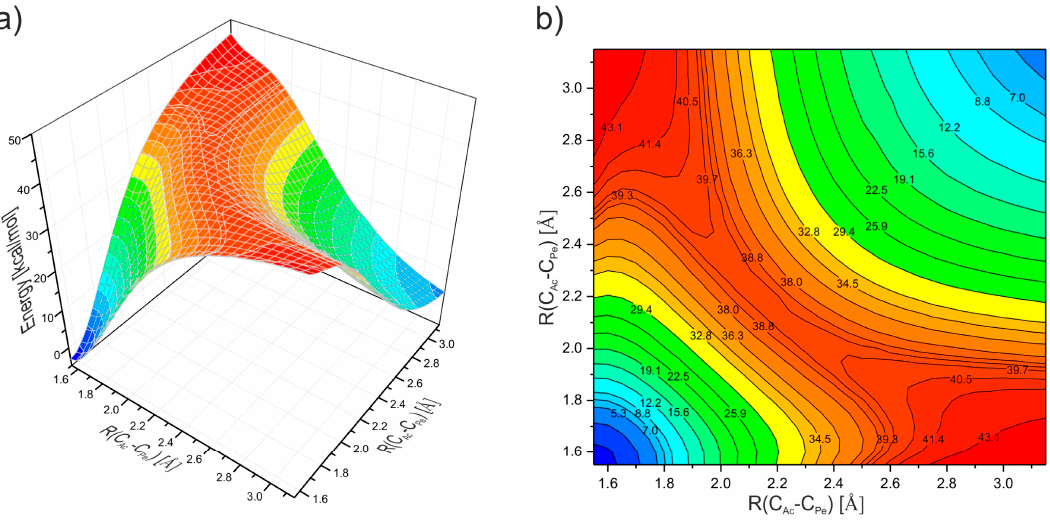
Figure 7. ( a ) Potential energy surface (PES) as a function of C Ac -C Pe distances for the cycloaddition reaction of diphenylacetylene with perylene. ( b ) Vertical projection of PES in the contour representation.